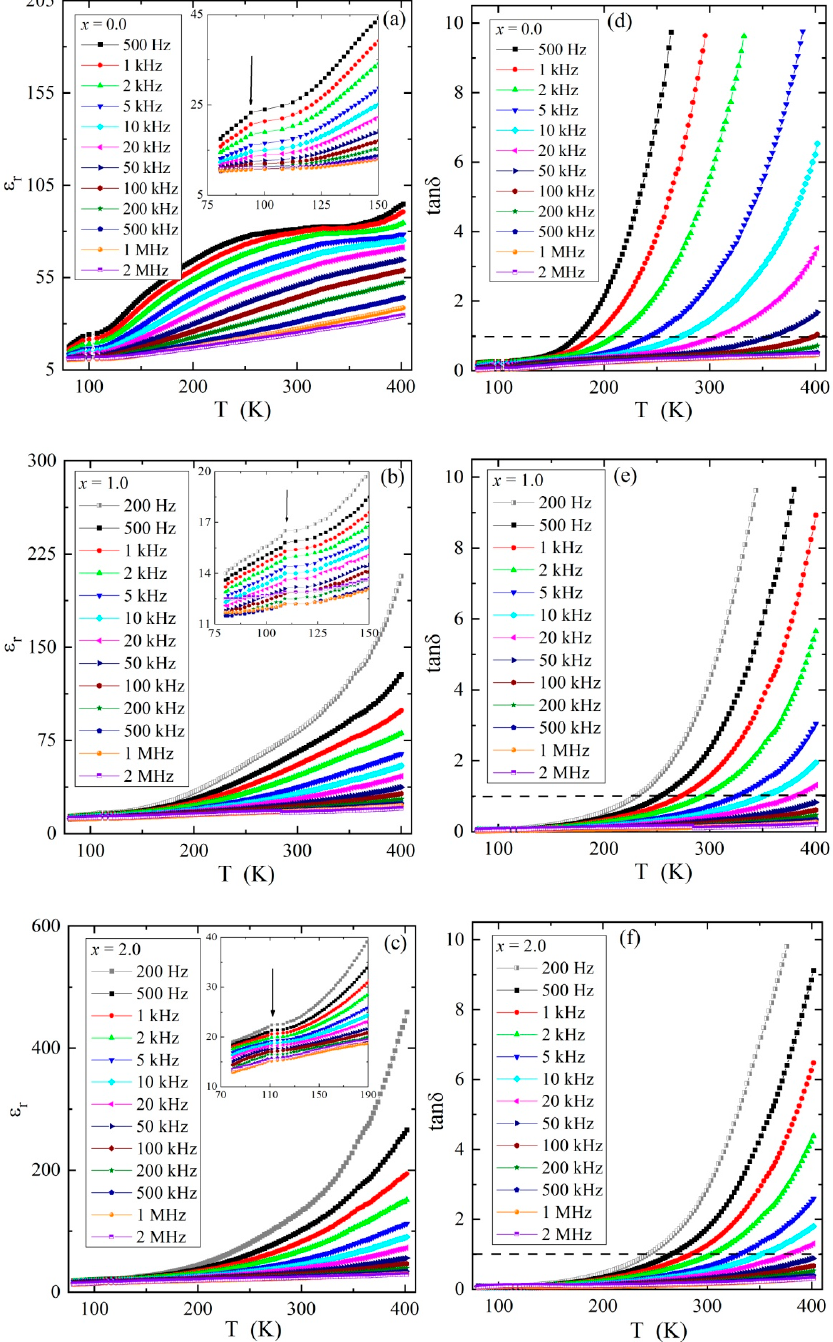
Figure 8. Dielectric constant ε r (x = 0.0 for ( a ), x = 0.1 for ( b ), x = 0.2 for ( c )) and loss tangent tan δ ( x = 0.0 for ( d ), x = 0.1 for ( e ), x = 0.2 for ( f )) vs. temperature T of Zn 2 − x Mg x InV 3 O 11 in the frequency range 200 Hz to 2 MHz. Insets: There was a change in the T-dependence of ε r in the vicinity of 94 K (for x = 0.0 in a ), 109 K (for x = 1.0 in b ), and 111 K (for x = 2.0 in c ), which are marked with vertical arrows. Horizontal dashed lines in the tan δ vs. T dependences indicate the value of tan δ = 1.